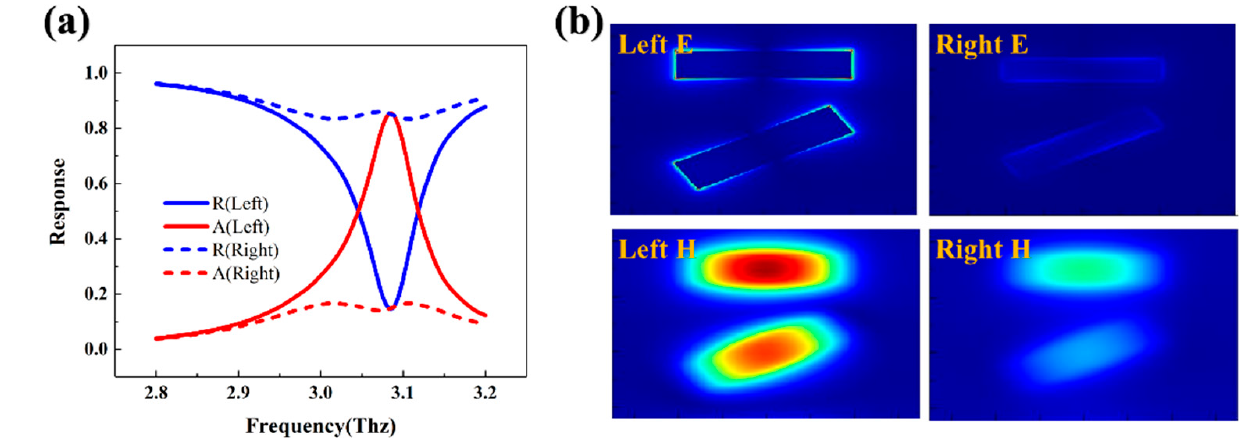
Figure 9. ( a ) Response spectrum (absorption and reflectance) of left and right -handed polarized light. ( b ) Electric and magnetic field distribution at the absorption peak (electric field at the top structure in the xy plane, and magnetic field in the middle xy section of the medium).